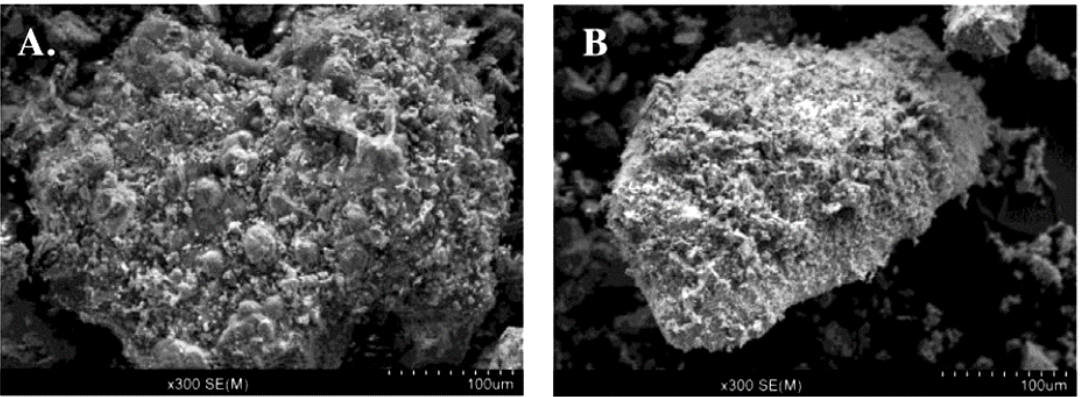
Figure 2. Characterization of crab carapace ( A ) and clamshell ( B ) powders by SEM [5].